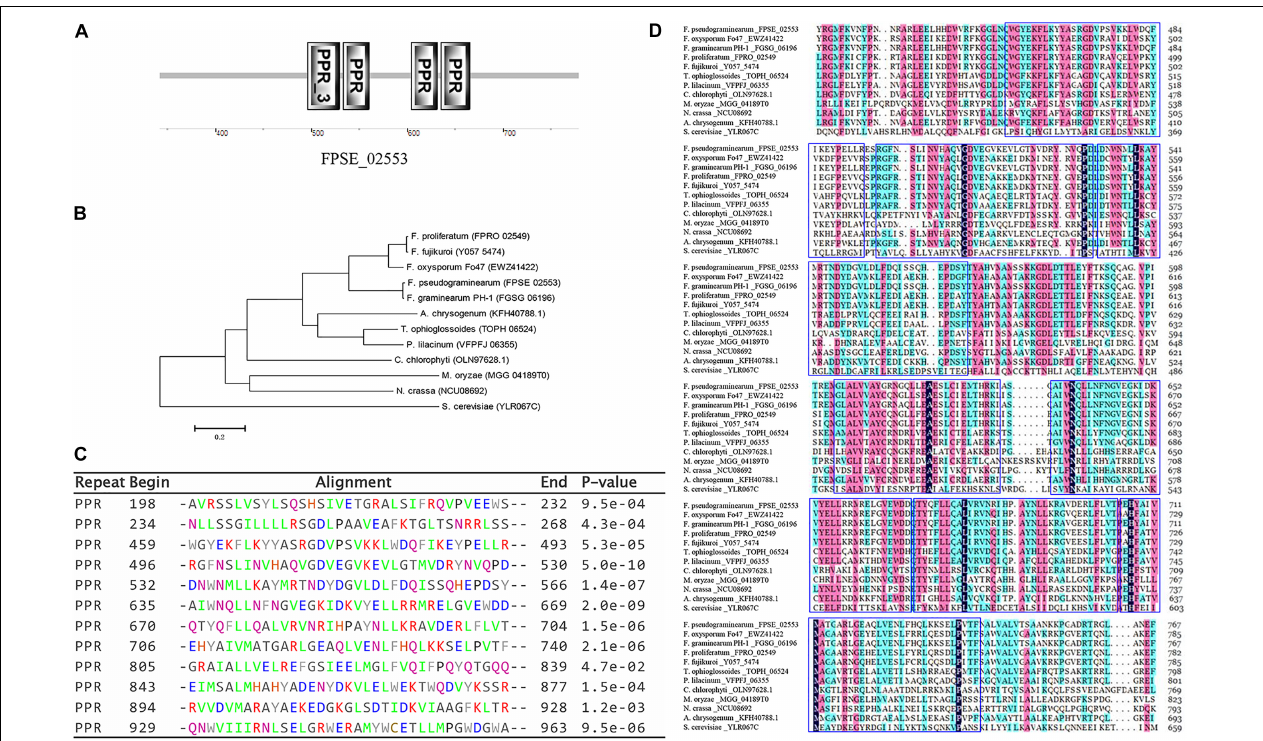
FIGURE 1 | Identification of the PPR-like gene FPSE_02553. (A) SMART functional domain prediction. (B) Phylogenetic tree showing the evolutionary relationships of fungal FpPPR1 proteins. Phylogenies were inferred using a PHYLIP-based program (MEGA 6) to create an unrooted phylogenetic tree. (C) The predicted protein was analyzed by TPRpred in the MPI Bioinformatics Toolkit (https://toolkit.tuebingen.mpg.de/#/tools/psiblast) and 12 PPR motifs were listed with their positions and P -value. (D) Sequence analysis was performed by DNAMAN software (partial alignment). The results show the conserved domains in proteins. F. pseudograminearum (FPSE_02553), F. graminearum PH-1 (FGSG_06196), F. oxysporum Fo47 (EWZ41422), F. fujikuroi coxI translation protein CYA5 (Y057_5474), F. proliferatum ET1 related to coxI translation protein CYA5 (FPRO_02549), T. ophioglossoides CBS 100239 Pentatricopeptide repeat-containing protein (TOPH_06524), P. lilacinum translation regulator (Cya5) (VFPFJ_06355), C. chlorophyti Pentatricopeptide repeat-containing protein, chloroplastic (OLN97628.1), N. crassa coxI translation protein CYA5 (cya-5) (NCU08692), M. oryzae (MGG_04189T0), A. chrysogenum ATCC 11550